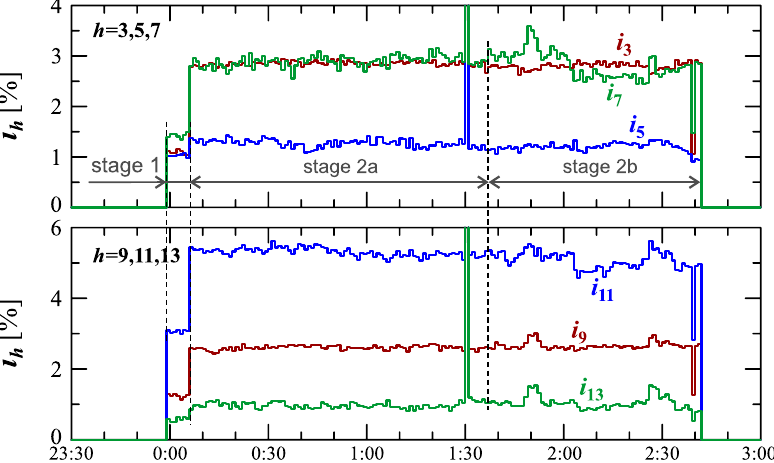
Figure 19. The characteristics of odd harmonics of the current i h = f ( t ) from the order h = 3 to 13 for Case